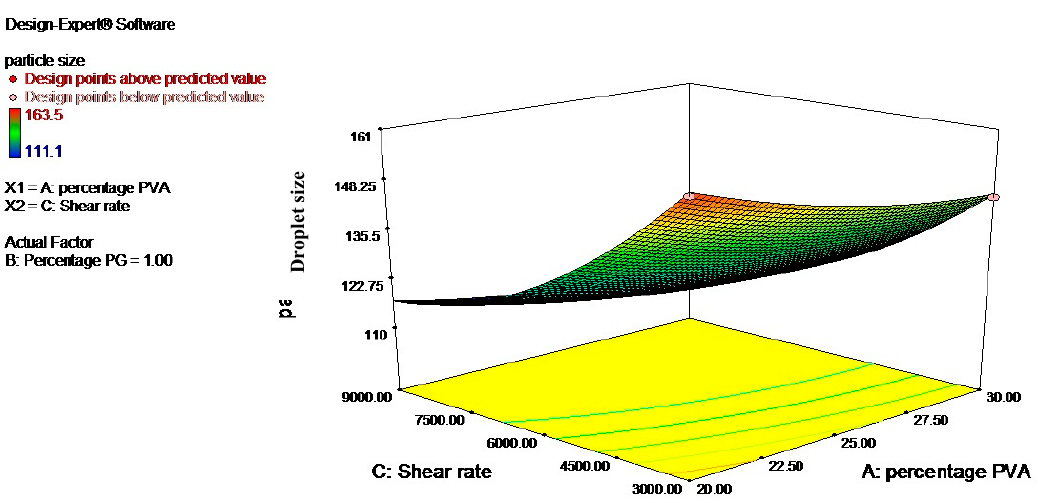
Figure 2. Three-dimensional surface graphs showing the effect of percentage PVA and shear rate on droplet size; percentage PG was kept constant.